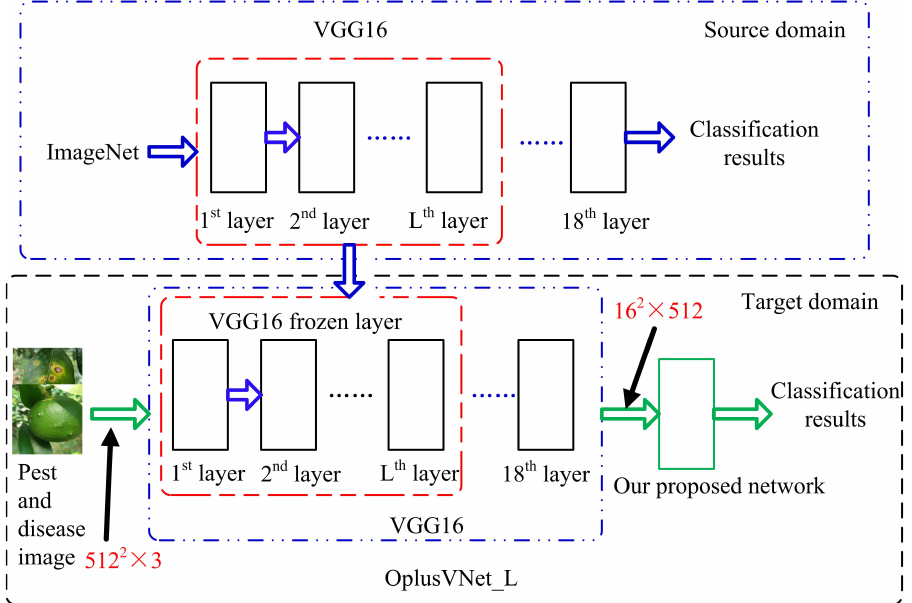
Figure 2. Transfer learning network based on our proposed